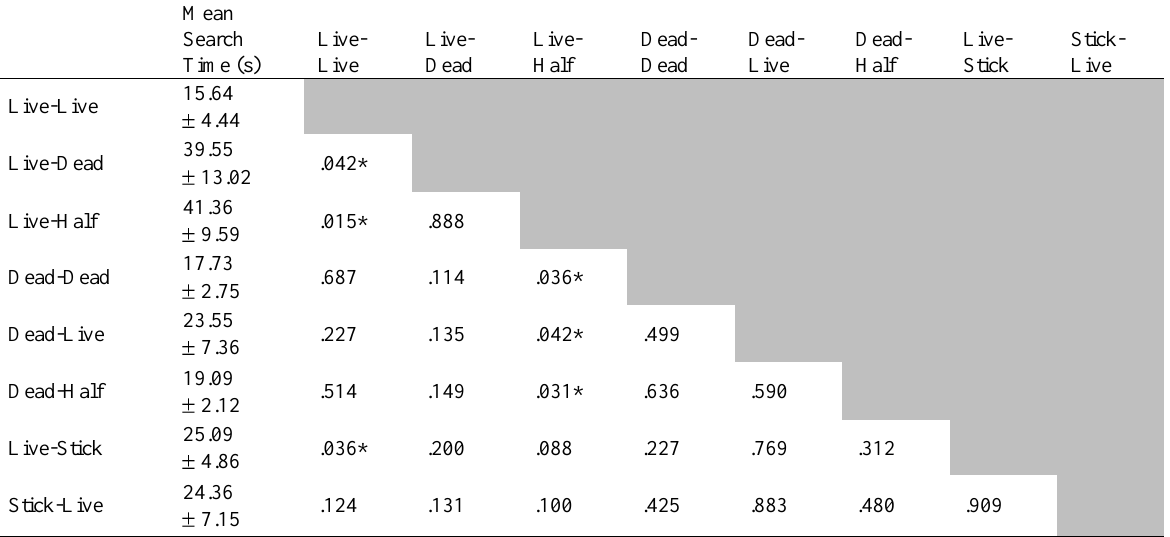
Mean Search Time (s)